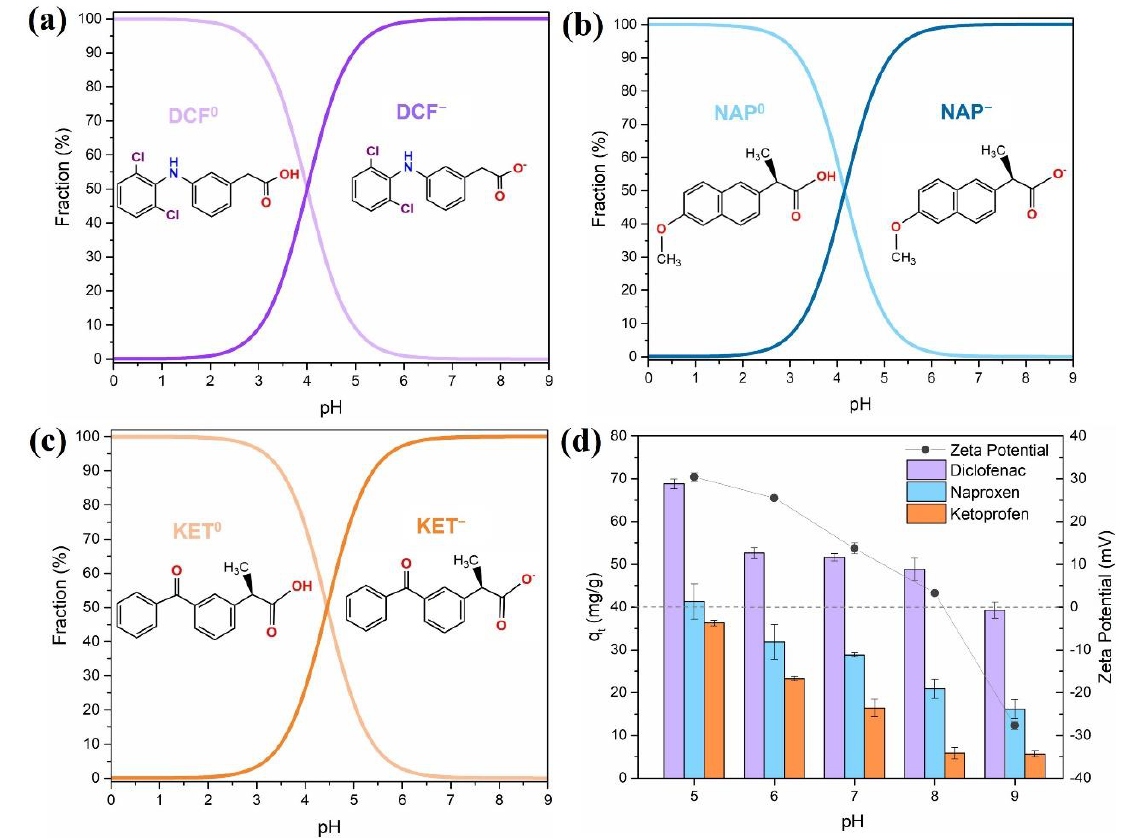
Figure 4. Speciation of ( a ) diclofenac (DCF), ( b ) naproxen (NAP), and ( c ) ketoprofen (KET) as a function of pH in aqueous solution, and ( d ) effect of the pH of the medium (from 5 to 9) on the adsorption of DCF, NAP, and KET (50 mg/L, 5 h contact time, sorbent dose 0.5 mg/mL) using Fe 3 O 4 @SiO 2 /TMC/GPTMS particles and zeta potential values of Fe 3 O 4 @SiO 2 /TMC/GPTMS particles. Error bars correspond to standard deviations obtained from two replicates.